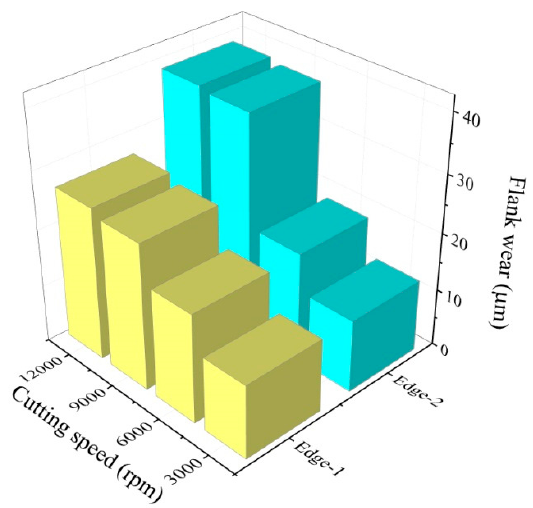
Figure 4. Flank wear variation with cutting speed after drilling 30 holes.